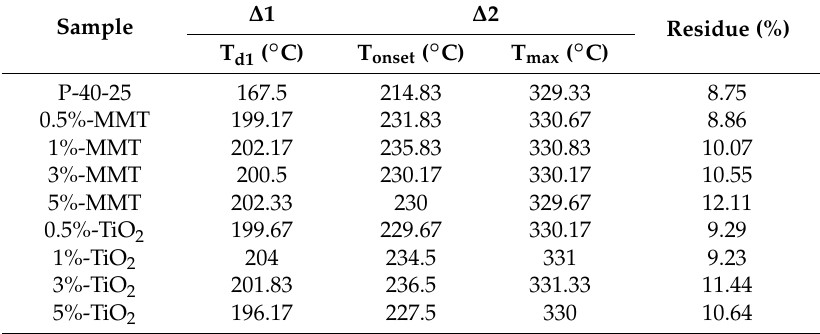
Figure 5. Thermogravimetric curves of ( a ) P‐40‐25 incorporated with MMT and ( b ) P‐40‐25 incorporated with TiO 2 . Table 2. Thermogravimetric analysis (TGA) results of P‐40‐25 incorporated with MMT and TiO 2 .